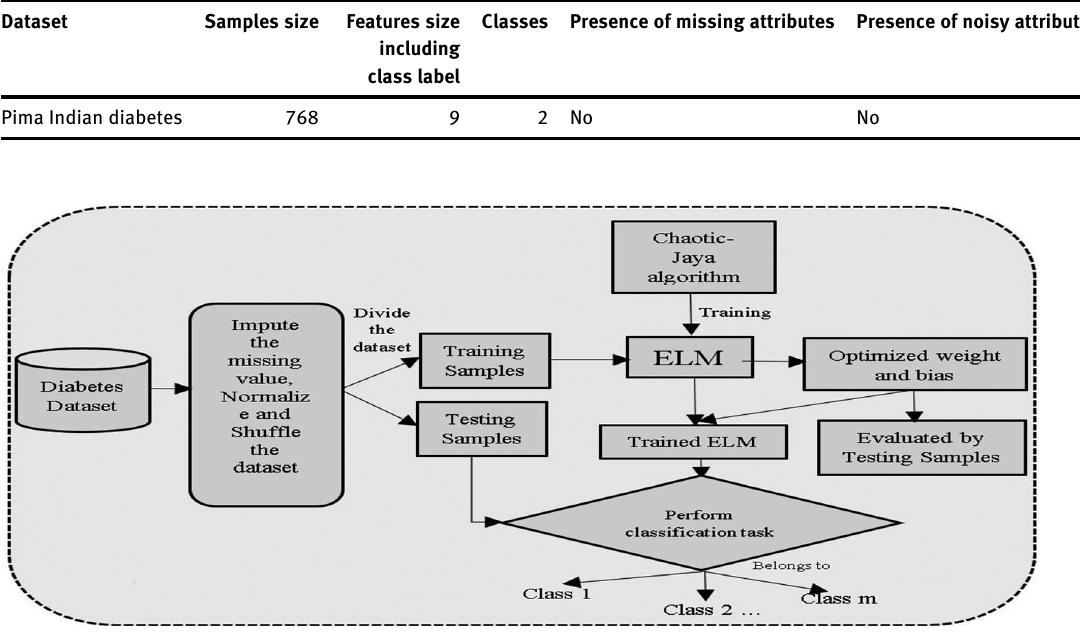
Figure 2: Block diagram of the proposed CJaya-ELM model.